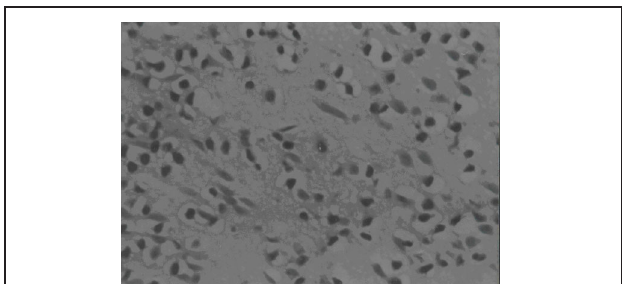
FIGURE 6 | Immunohistochemical findings of MSCs group at 14 days after transplantation.